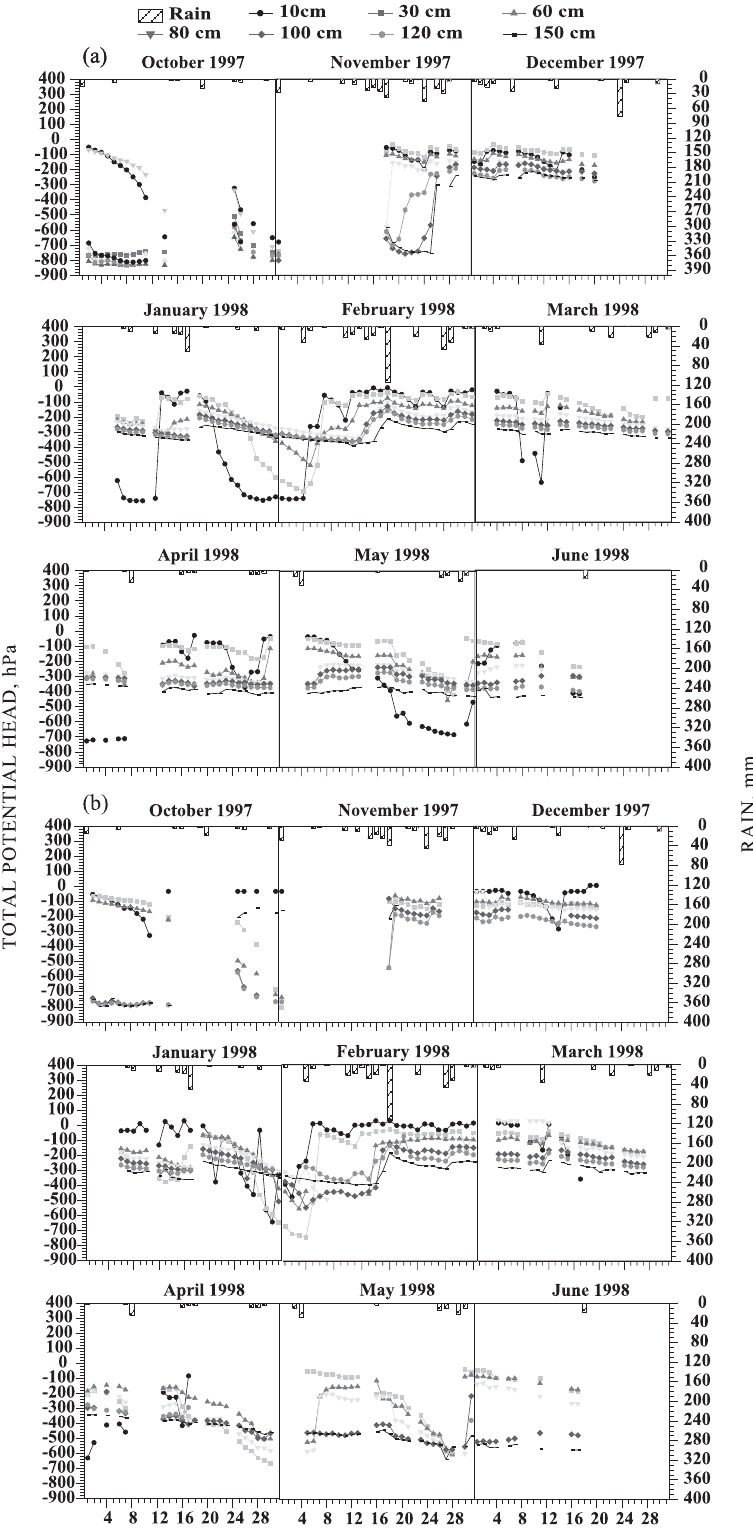
Figure 7. Daily variations of the total water potential head in tensiometric station 1 (TS1) situated in the summit segment (a), and in tensiometric station 2 (TS2) situated at the transition between the summit and upper shoulder segments (b). Blank spaces in the graphs correspond to periods where no measurements could be made or to problems with the functioning of the